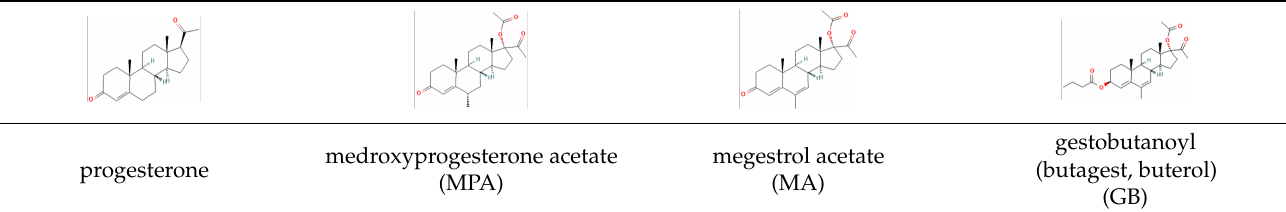
Table 1. Progesterone and pregnane progestins with the anticancer and chemosensitizing activities.